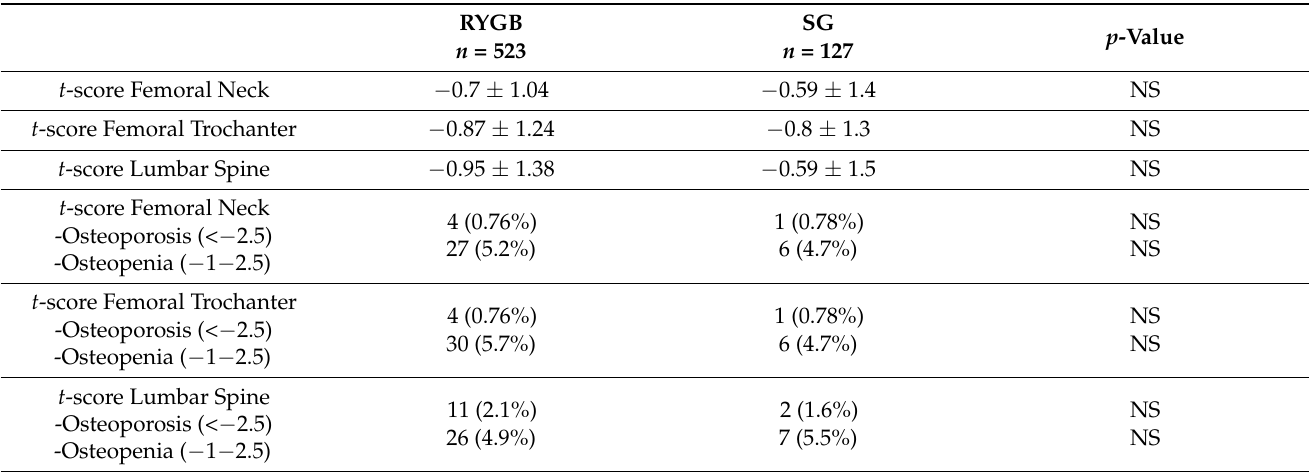
Table 4. Two years postoperative densitometric values and osteoporosis and osteopenia rates between groups.